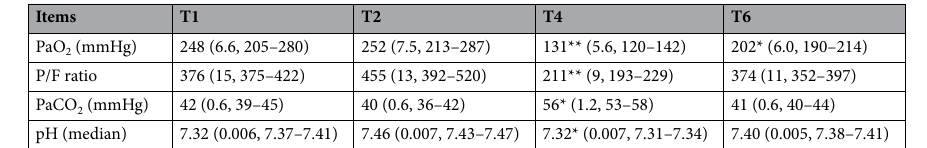
Table 3. Results of the arterial blood gas analysis of the 67 patients included in the study. The Mann–Whitney U test was used to analyze continuous variables. Compared with T1, * p < 0.05, ** p < 0.01. PaO 2 , oxygen in arterial blood; IQR, inter quartile range; PaCO 2 , carbon dioxide in arterial pressure; P/F ratio, oxygen in arterial blood/fraction of inspired oxygen. Continuous values are expressed with median (standard Error, interquartile range).